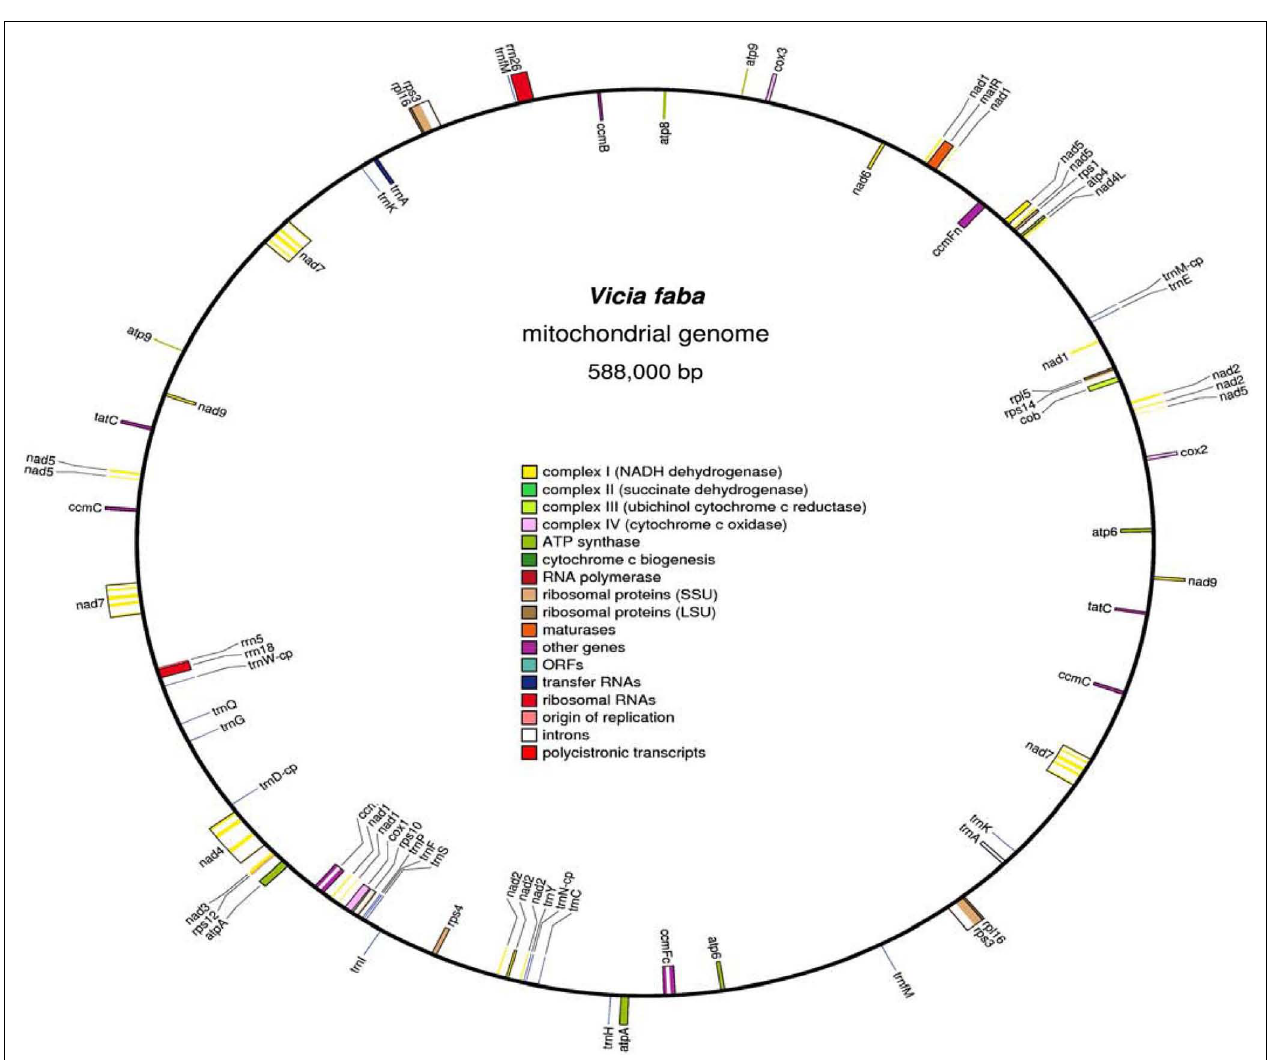
FIGURE 1 |The circular map of Vicia faba mitochondrial genome. Clockwise and counter-clockwise strands are drawn on the inside and outside of the outer circle, respectively. GC content is shown in the inner circle.The map was drawn by using OGDRAW (Bock et al., 2007).